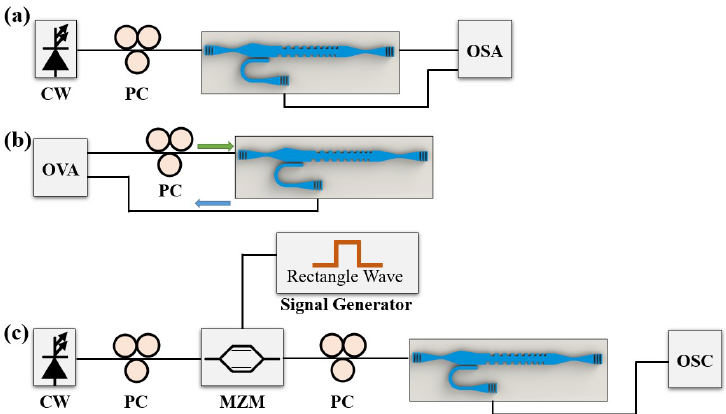
Figure 5. Experimental setups of the reflection and transmission spectrum measurement ( a ), the group delay measurement ( b ), time-of-flight measurement ( c ). CW: continuous wave laser; PC: polarization controller; OSA: optical spectrum analyzer; OVA: optical vector analyzer; MZM: Mach-Zehnder modulator; OSC: